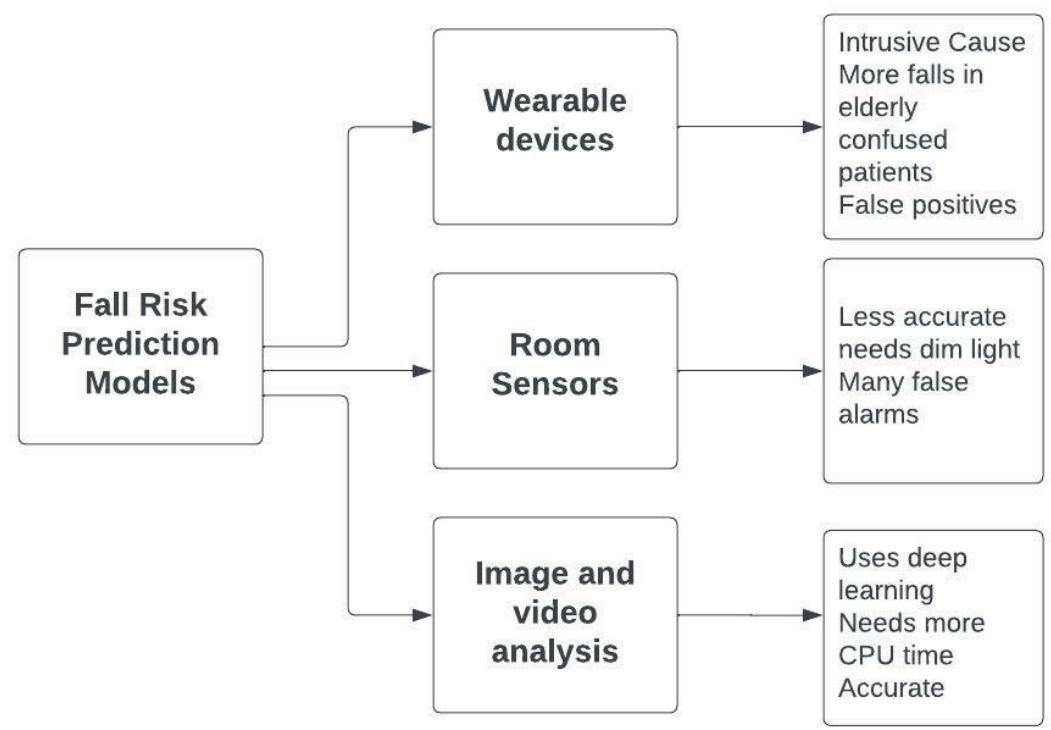
Figure 1. Fall risk prediction models can consist of wearable devices, room sensors or image and video analysis.